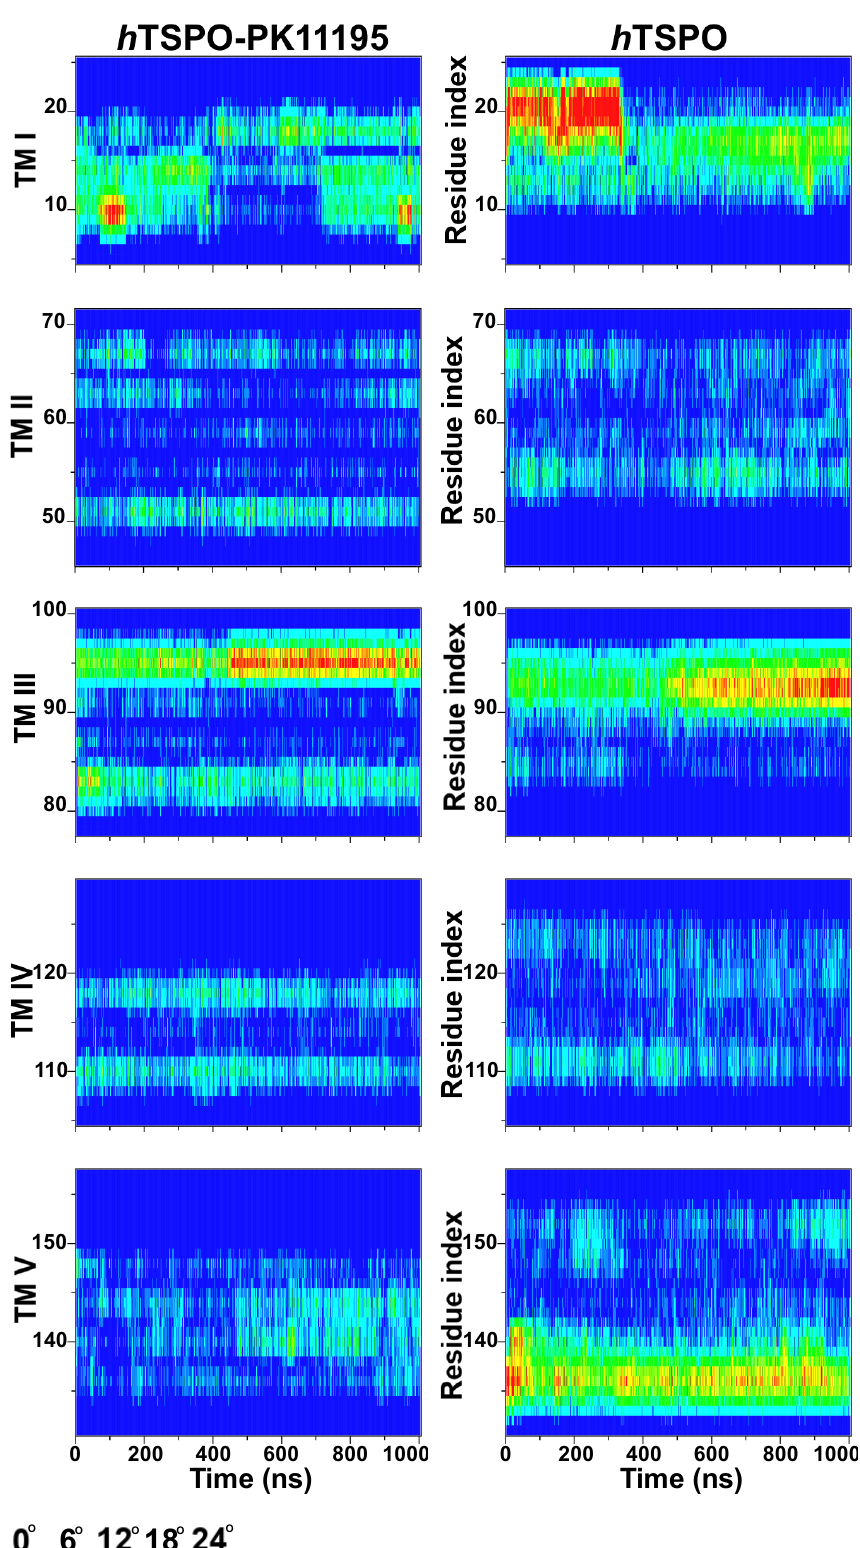
Figure 5. Analysis of the flexibility of each TM domain (TM I–TM V) in h TSPO–PK11195 and h TSPO structural models by means of Bendix [67]. y-axis: residue index number corresponding to the residues composing individual TM domain; x-axis: simulation time. The color scale indicates changes in helix angle/bending during the MD simulations, from blue: <6 ◦ to red: >24 ◦